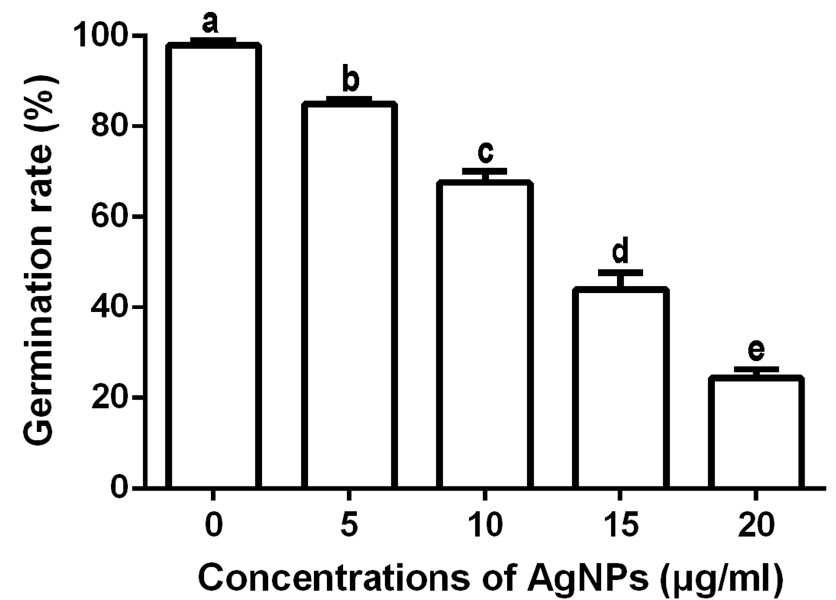
Figure 5. Effect of the synthesized AgNPs of different concentrations on spores’ germination rate of F. graminearum strain PH − 1. The biosynthesized AgNPs at four different concentrations were able to effectively suppress the spore germination. Data are a mean value ± standard error of three replicates, and bars with the same letters are significantly different in LSD test ( p < 0.05).